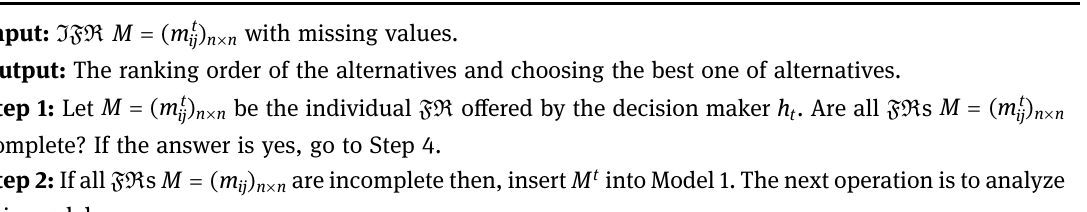
Algorithm 1 An algorithm to GDM with FR ( Figure 1